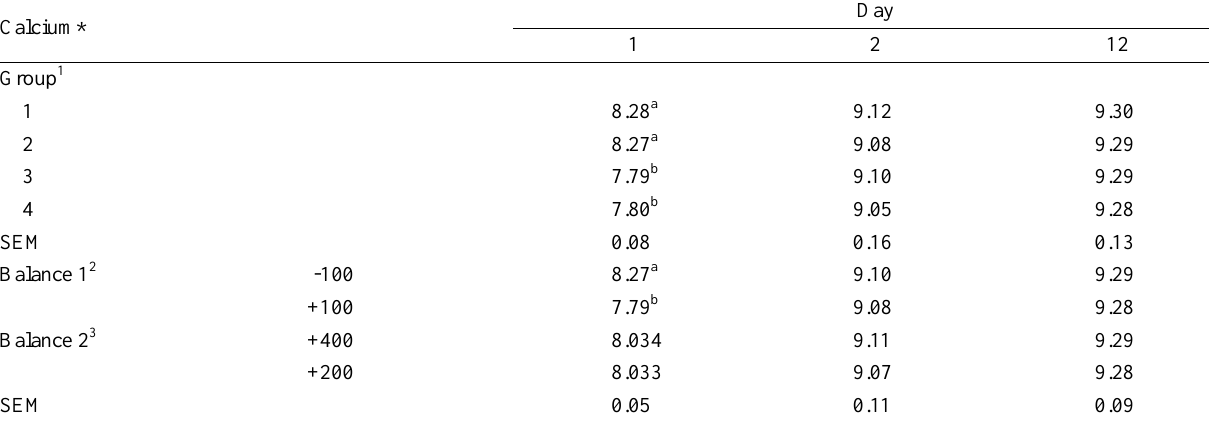
Table 3. The effect of dietary cation-anion difference on plasma calcium concentration postpartum